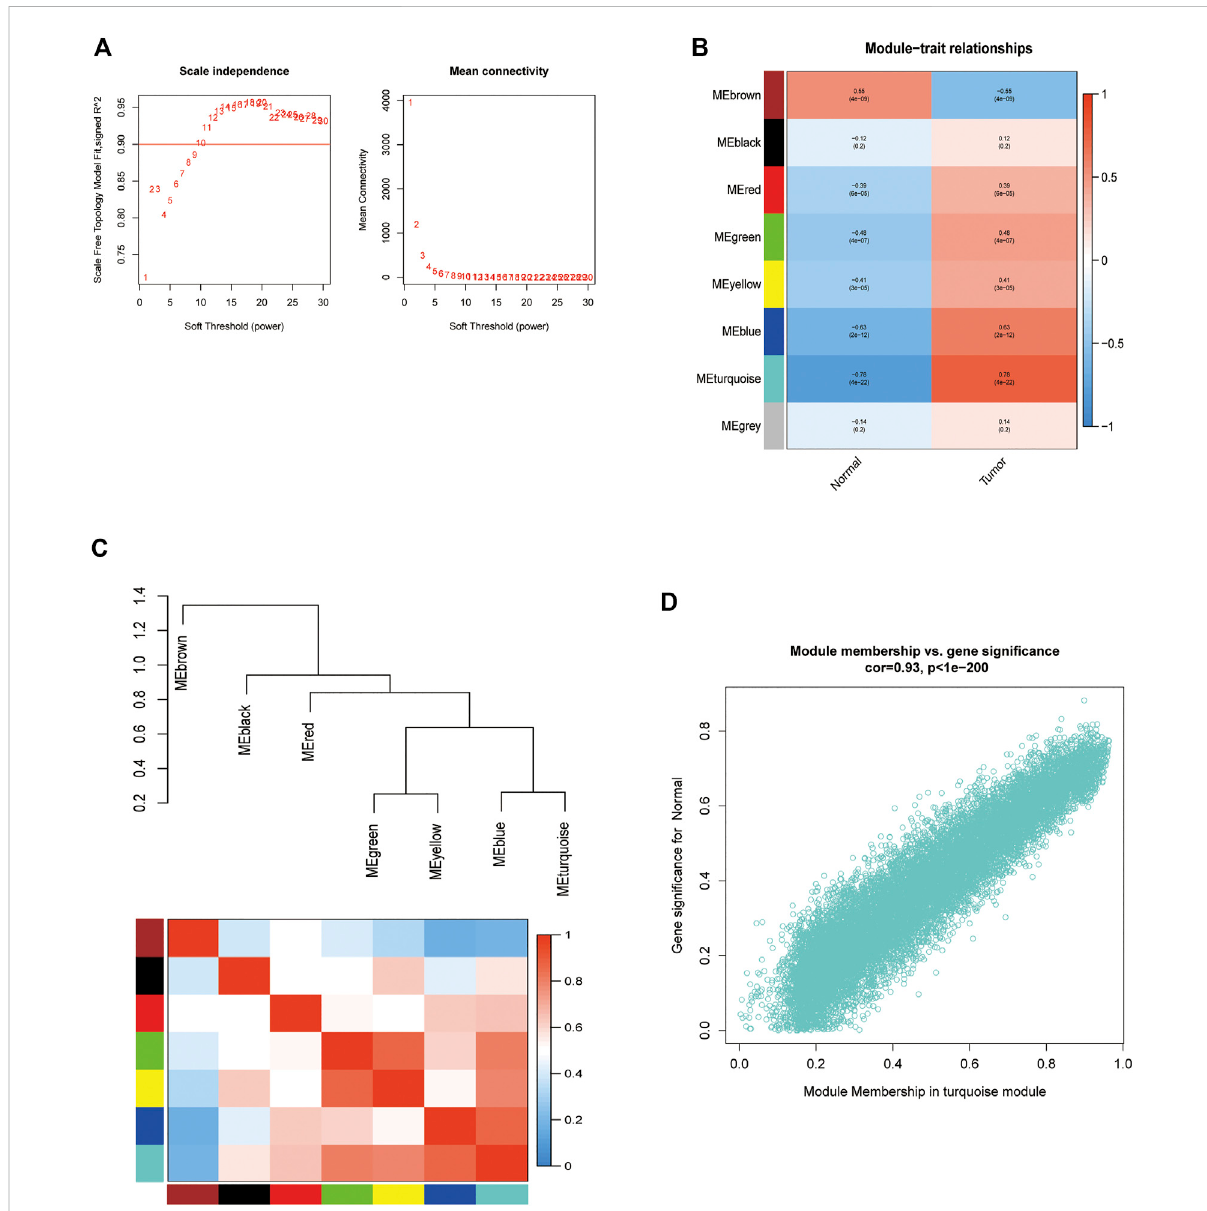
FIGURE 4 Enrichment levels in genomic weighted gene co-expression network analysis (WGCNA). (A) . Selection of soft thresholds. (B,C) Correlation of module eigengenes with glioblastoma. (D) Correlation of turquoise eigengenes with